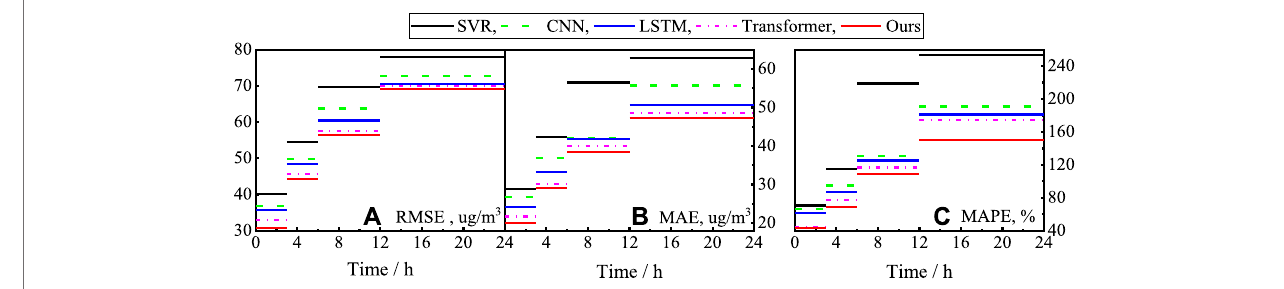
FIGURE 10 | Comparisons of different methods for multi-step prediction results for the next 24 h on Beijing dataset.